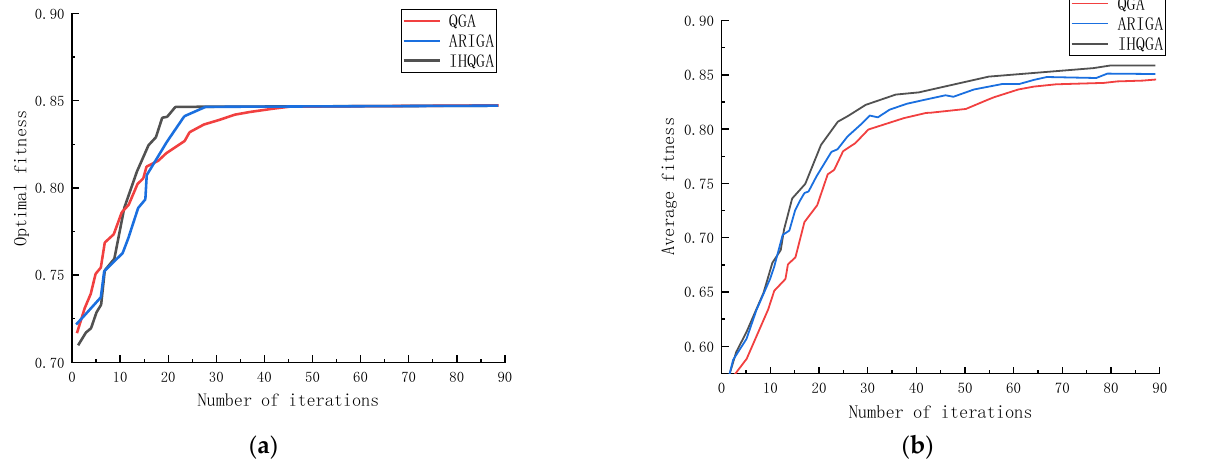
Figure 6. Optimal fitness and average fitness change process: ( a ) Optimal fitness; ( b ) Average fitness.